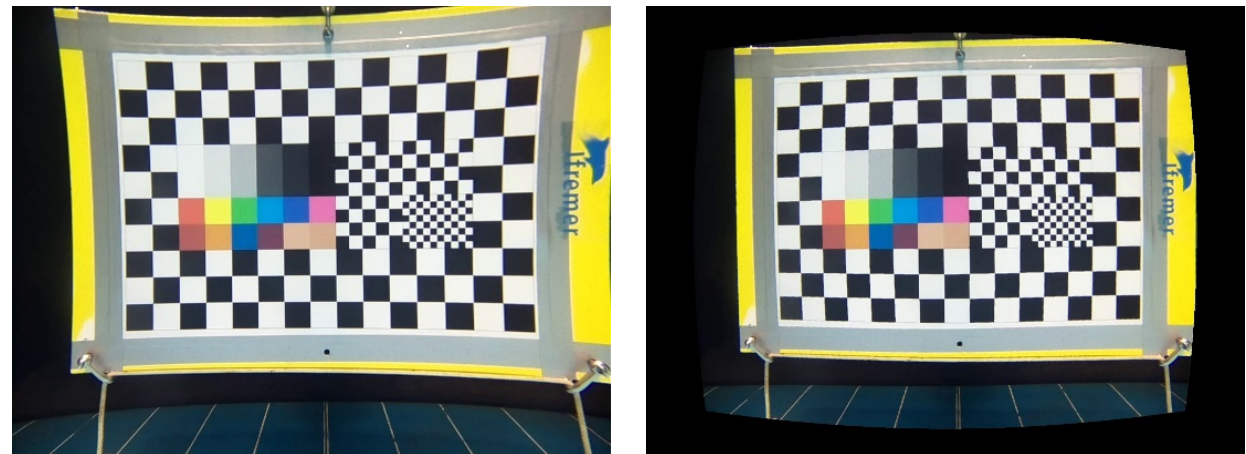
Figure 10. KOSMOS image of the pattern test at 1 m before ( left ) and after ( right ) correcting for distortion.